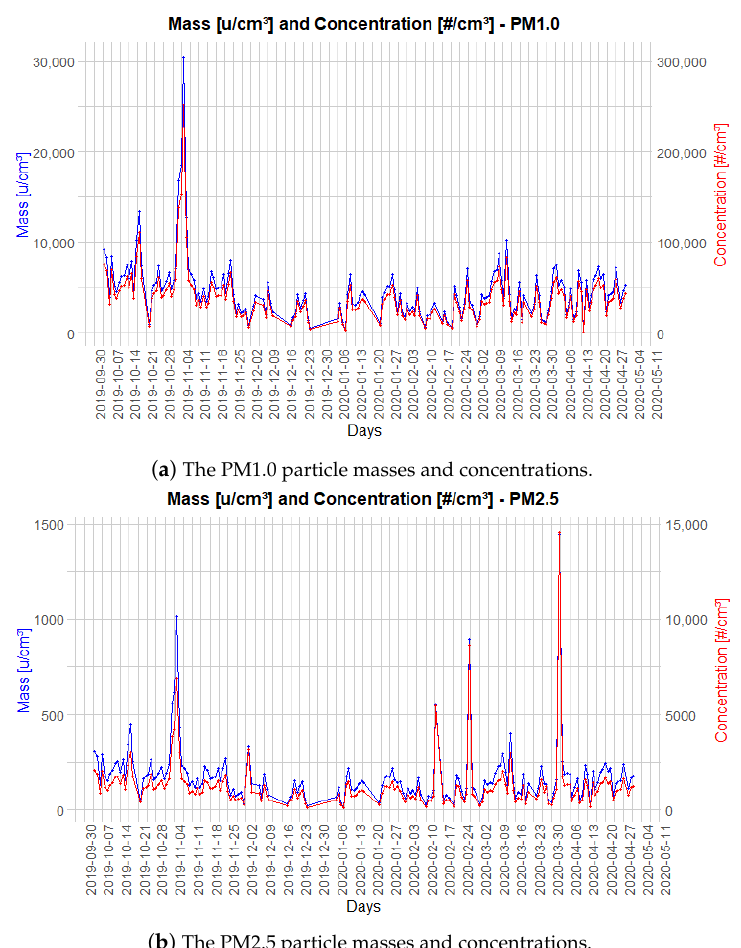
Figure 2. The particle masses and concentrations from October 2019 to April